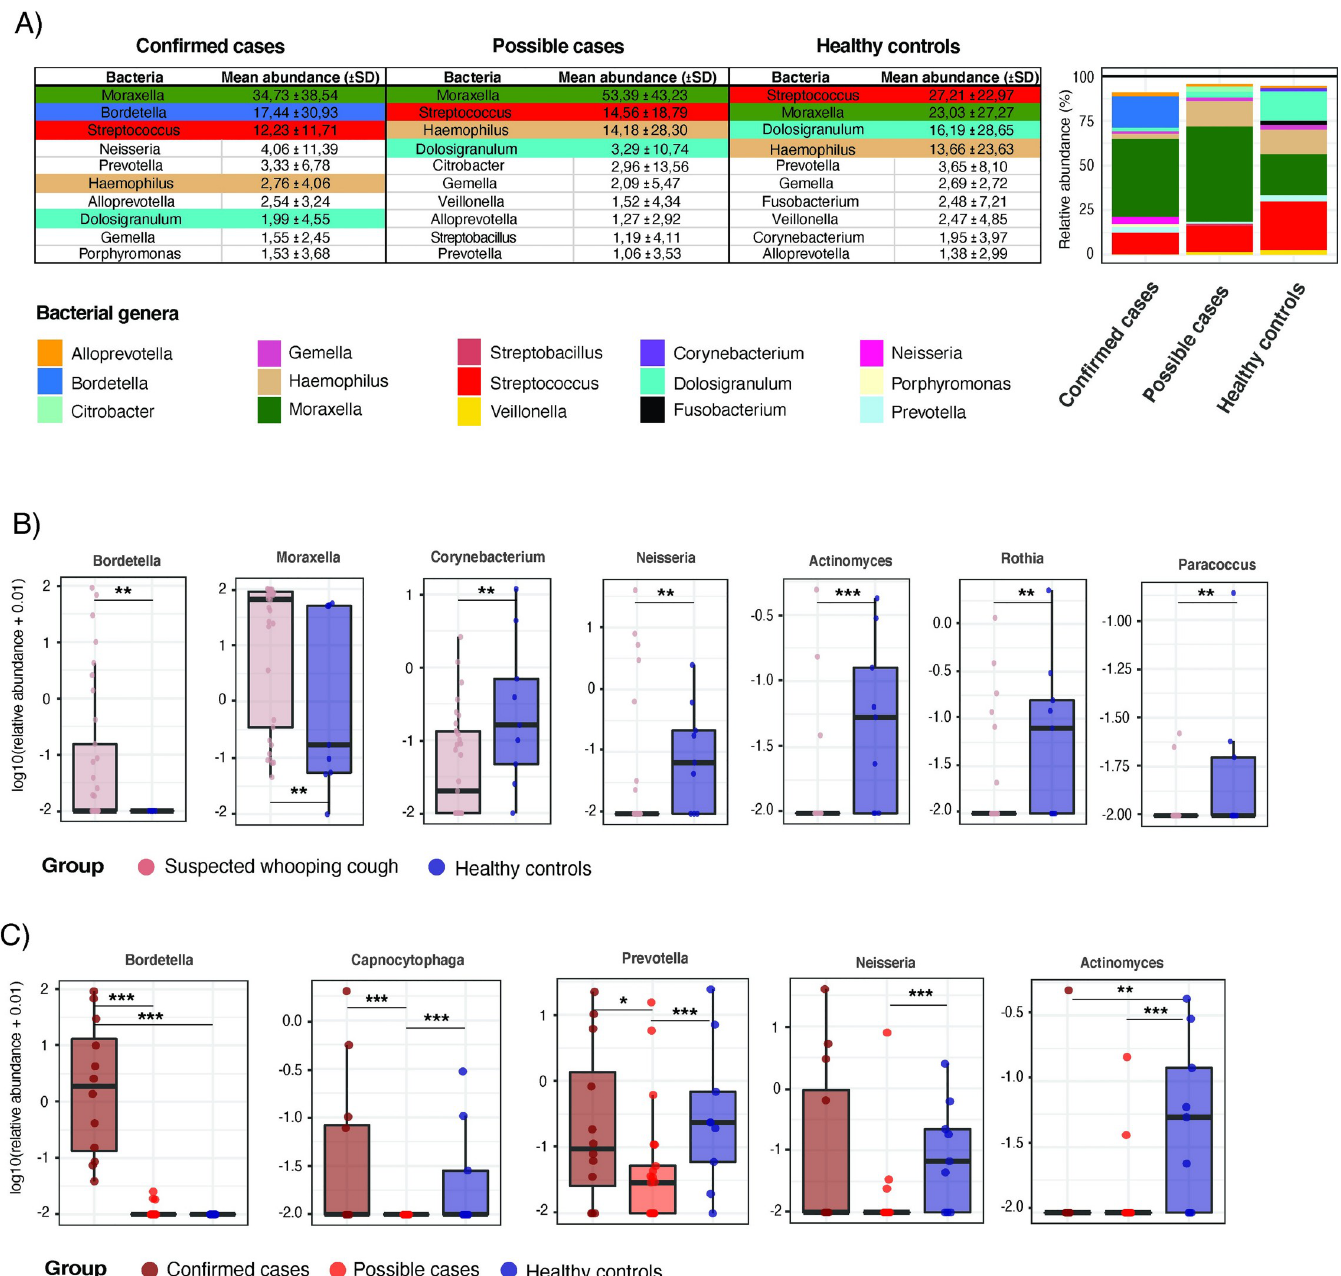
Fig 2. Nasopharyngeal microbiota bacterial genus composition profiling and differences between whooping cough children and healthy controls. A) Table showing the top ten abundant bacterial genera based on their mean relative abundance per group (mean ± SD). Color-code is kept through the groups to highlight the most abundant genera. On the right, barplots showing the mean contribution of the ten top bacterial genera per group in relation to the overall gut microbiota composition. B) Boxplots showing the relative abundance of those bacterial genera with a differential abundance between suspected whooping cough and healthy groups based on a Wilcoxon Rank Sum test (p-value significant threshold set to 0.05). Differences between groups are shown as � p-value < 0.1, �� p-value < 0.05, ��� p -value < 0.01. C) Boxplots showing the relative abundance of those bacterial genera with an overall differential abundance between confirmed cases, possible cases and healthy groups based on a Kruskal-Wallis test (p-value significant threshold set to 0.05). Further unadjusted pairwise-statistical differences between groups are shown as � p-value < 0.1, �� p-value < 0.05, ��� p -value < 0.01.